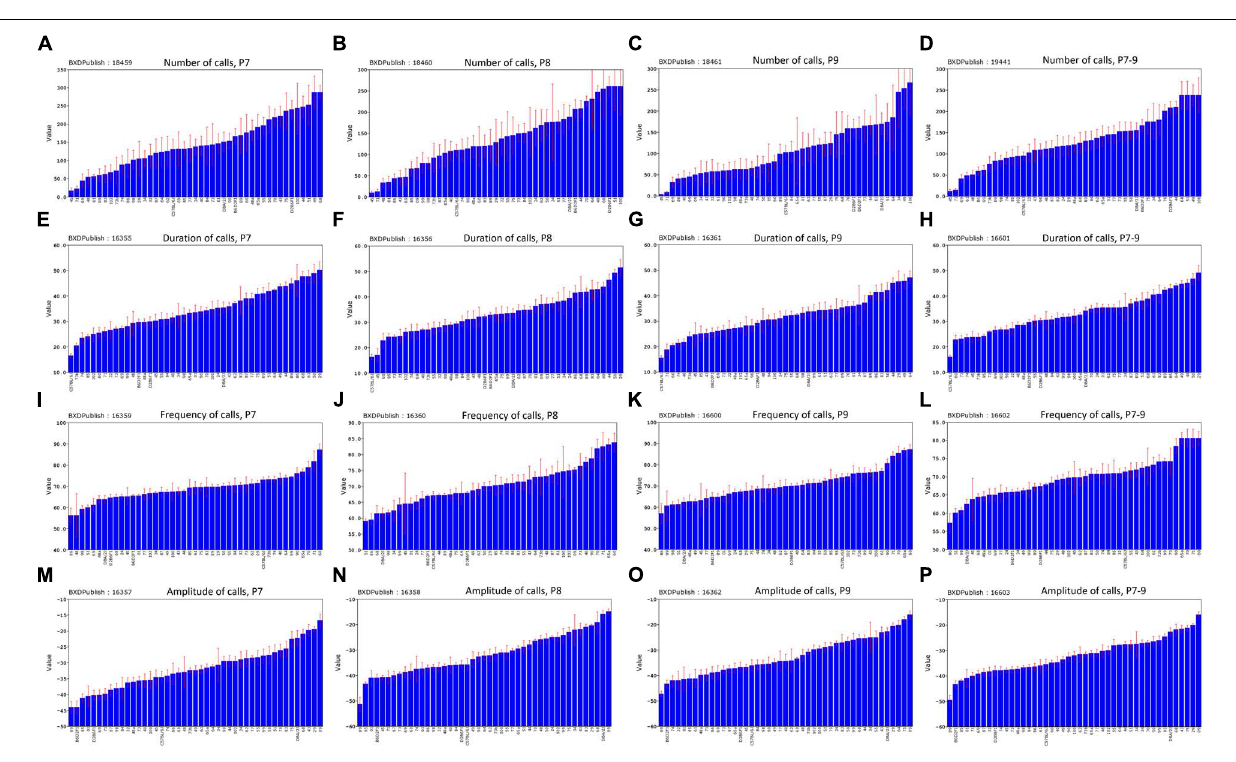
FIGURE 8 | Distribution of mean values across the strains of the BXD family for the four quantitative traits, postnatal days (P)7–9 and combined P7–9. (A–D) Number of calls, (E–H) duration of calls, (I–L) frequency of calls, (M–P) amplitude of calls. BXDPublish is the trait ID in GeneNetwork, with which the trait can be